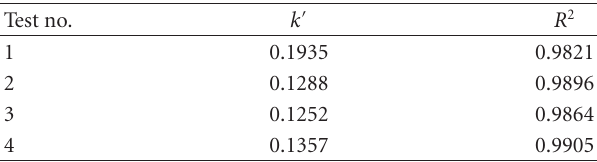
Figure 2: The changes in phenol concentration during the photocatalytic process. Table 1: Apparent first-order rate constants ( k (cid:3) ) and linear regres- sion coe ffi cients ( R 2 ) of phenol photodecomposition reactions.